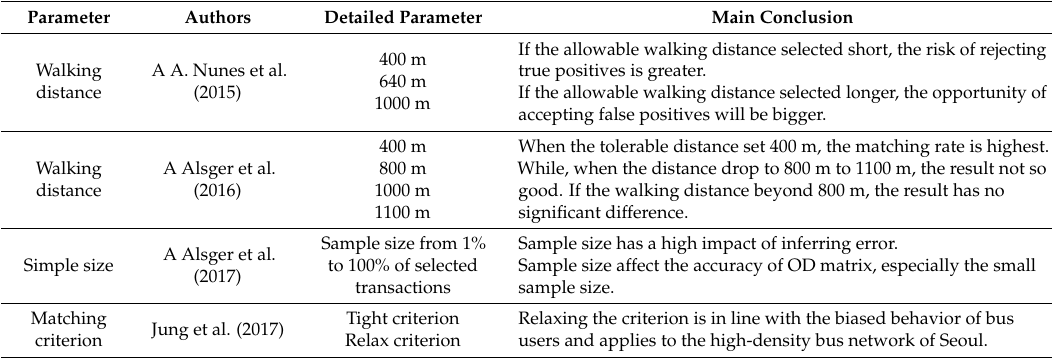
Table 8. Sensitivity analysis list of recent